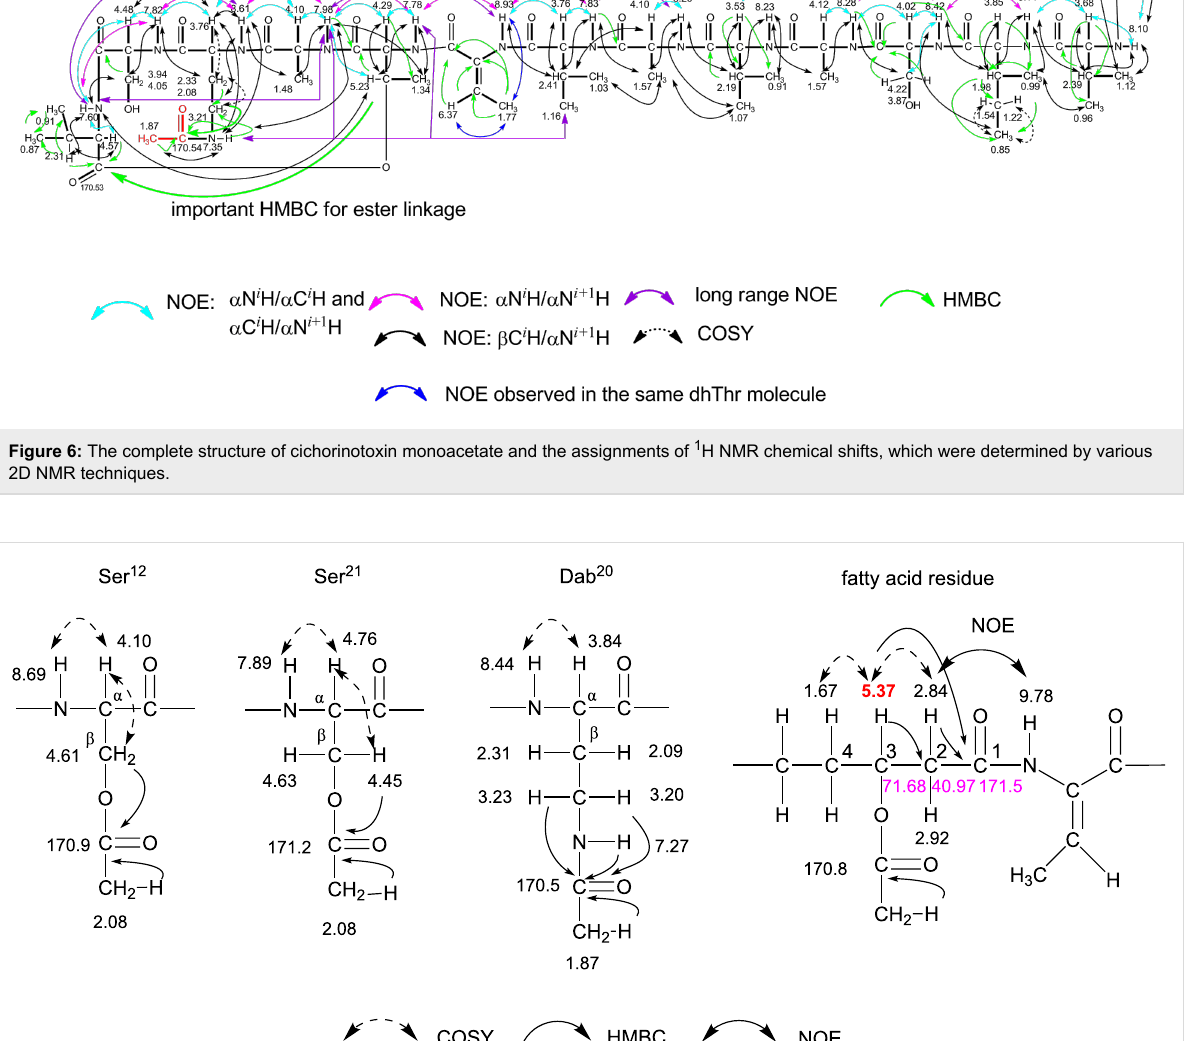
protons of Ser 12 , Ser 21 and Dab 20 each had distinct HMBC correlations with one of the acetyl carbonyl carbons, the signals of which were confirmed by clear HMBC cross peaks for the acetyl methyl protons (see Figures S13B–S13D in Supporting Information File 1). Thus, the hydroxy groups of the two Ser